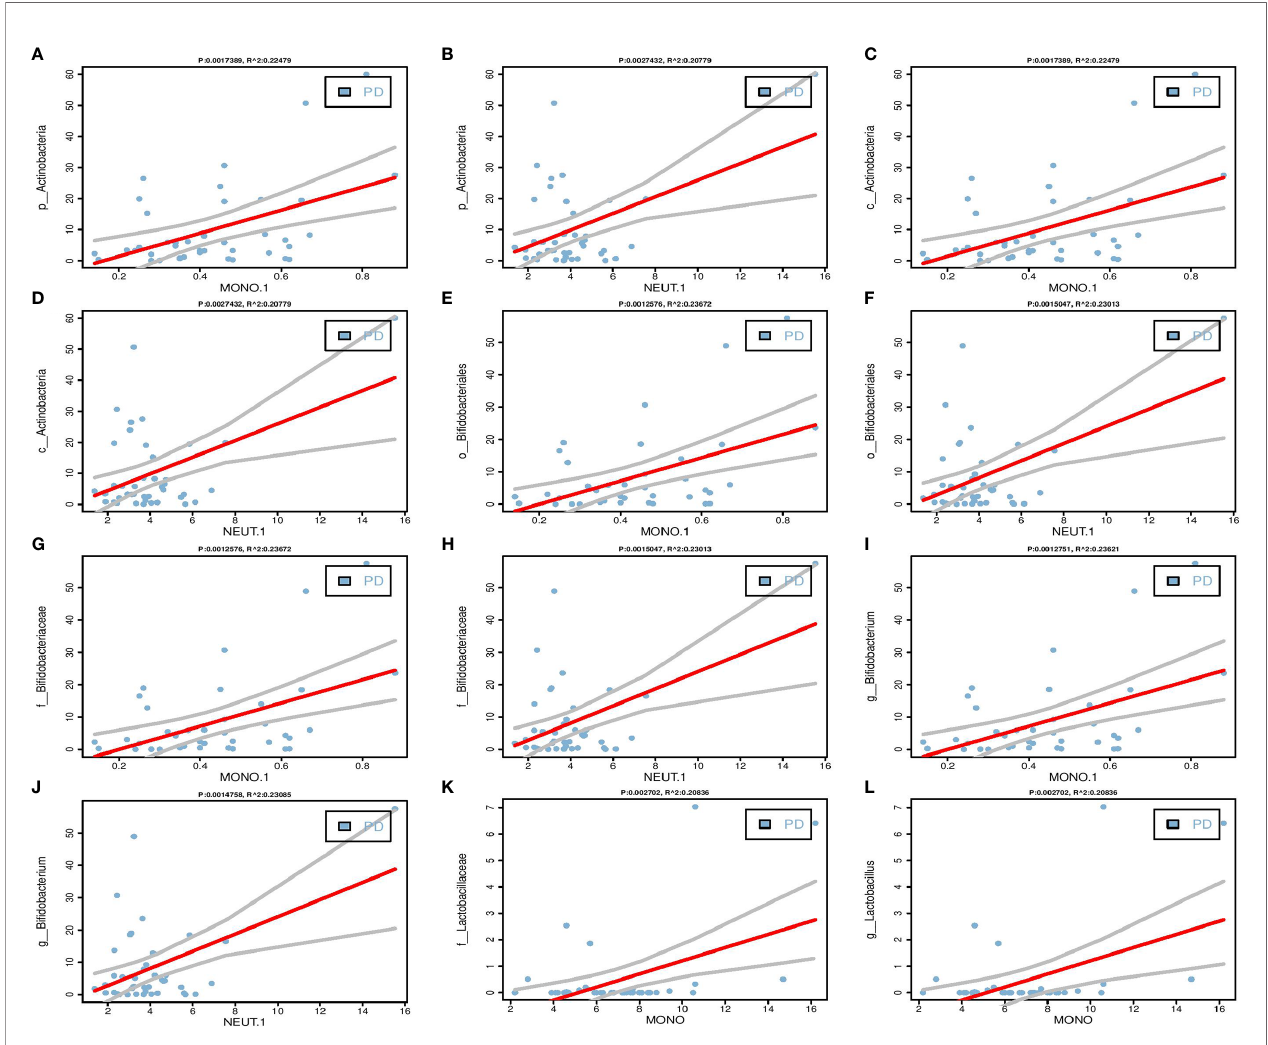
FIGURE 3 | Linear regression between candidate biomarkers and in fl ammatory indicators. (A – J) Signi fi cant positive correlations between Actinobacteria phylum (p_Actinobacteria, c_Actinobacteria, o_Bi fi dobacteriales, f_Bi fi dobacteriaceae, g_bi fi dobacterium ) and MONO.1, NEUT.1. (K – L) Signi fi cant positive correlations between Firmicutes phylum (f_Lactobacillaceae, g_Lactobacillus ) and MONO. The Pearson correlation was calculated and tested using the “ cor.test() ” function. The linear regression analysis graph was plotted by the “ lm ”